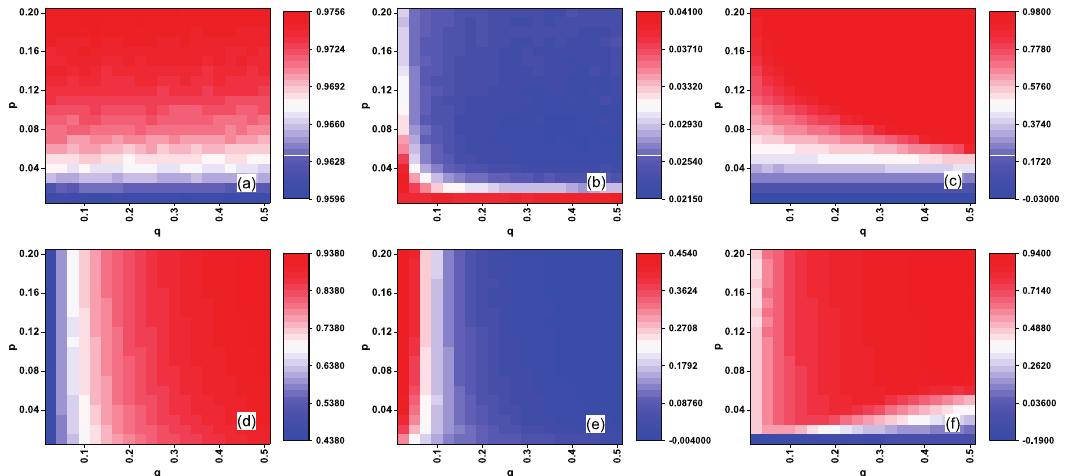
Fig 3. (Color online) The effectiveness of the EigenRank algorithm under malicious rating attack for the MovieLens data set: (a) the AUC values AUC ; (b-c) Δ AUC , the comparison of AUC between EigenRank algorithm and IBeta method (b), Vote e e e Aggregation method (c); (d) the recall R ( L ); (e-f) Δ R ( L ), the comparison of recall between EigenRank algorithm and IBeta c c method (e), Vote Aggregation method (f). The parameters q and p denote the ratio and the activity of spammers, respectively. q ranges from 0.025 to 0.5 in increments of 0.025 and p ranges from 0.01 to 0.2 in increments of 0.01. One observes that both the AUC and R c ( L ) of the EigenRank algorithm exceed their counterparts in the IBeta method and Vote Aggregation method for different ( p , q